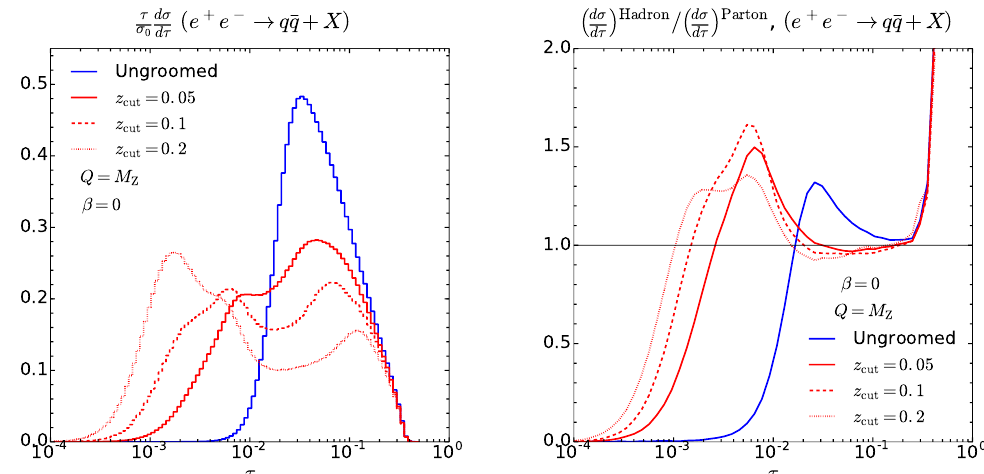
Figure 4 . Soft-drop thrust distribution generated with Pythia for three di(cid:11)erent values of the energy cut z cut , compared to ungroomed thrust. All plots are for (cid:12) =